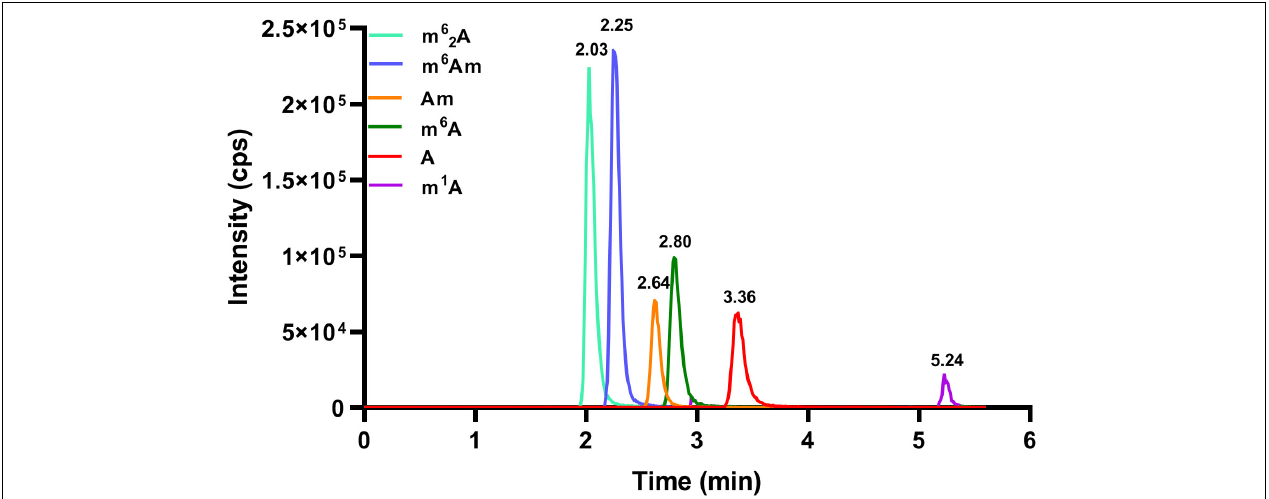
FIGURE 2 | The MRM chromatograms of A, m 6 A, m 1 A, m 6 Am, Am, and m 6 2 A standards. The concentration of each nucleoside standard was 25 nM, and the injection volume was 5.0 µ l.